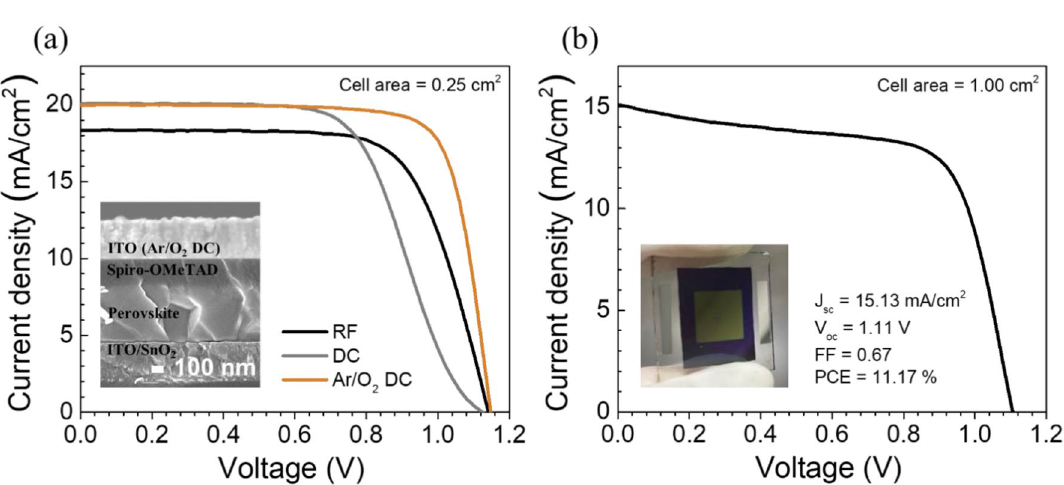
Figure 7. ( a ) Photoluminescence (PL) spectra of perovskite films exposed to AM1.5G. ( b – e ) Long-term stability of the unsealed devices based on the pristine and different external stimuli-treated perovskites stored in dark condition with humidity of 40–60%.